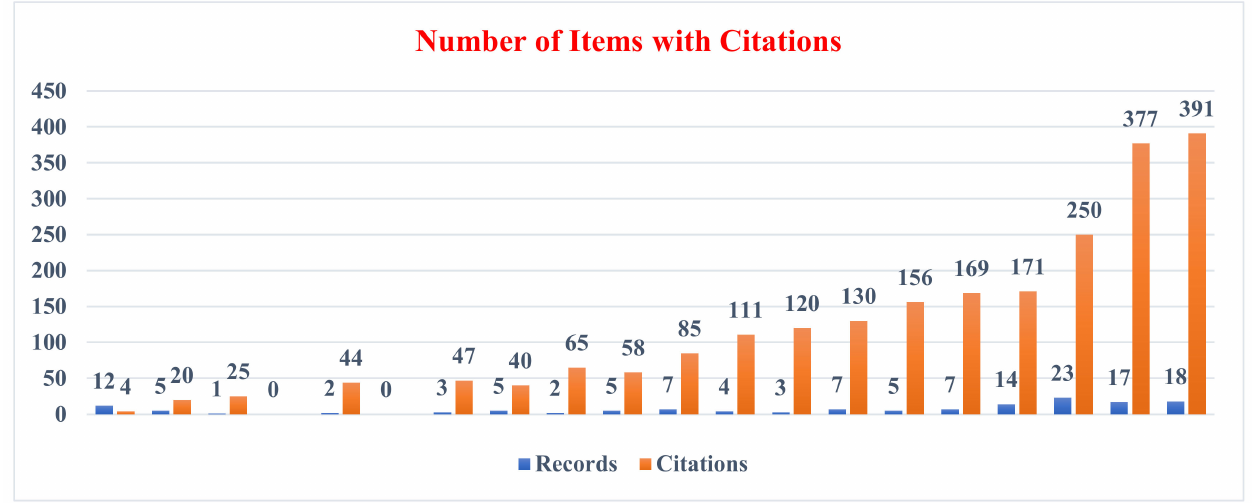
Figure 2. Number of records with citations in health sciences research.